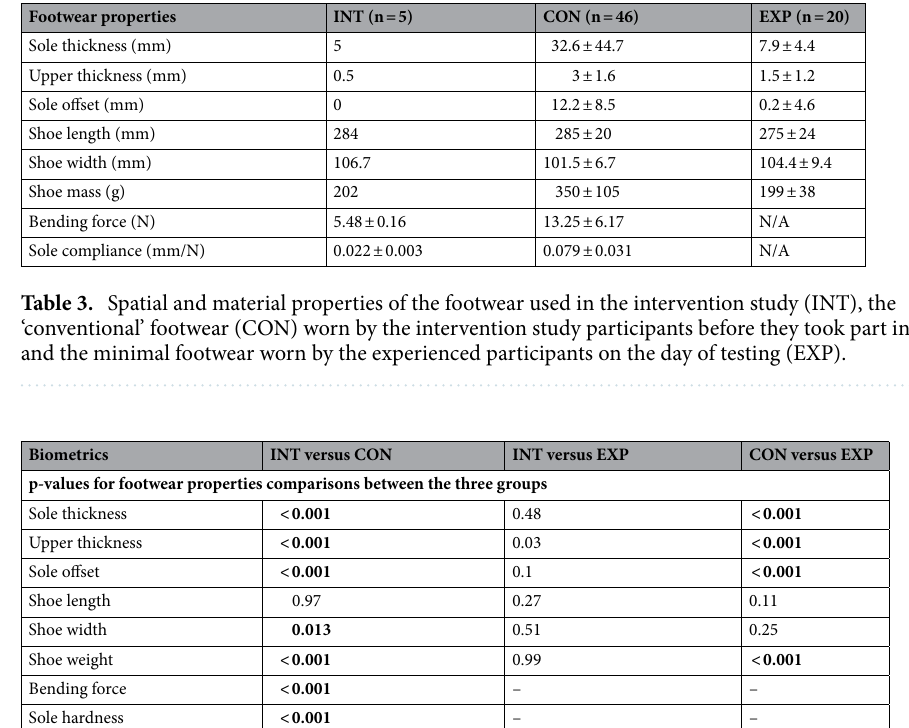
Table 4. Spatial and material properties: test results of the statistical comparison between the footwear used in the intervention study (INT), the “conventional” footwear worn by all intervention study participants but before they took part in the study (CON) and the footwear worn by the experienced participants on the day of testing (EXP). Significance level is set at P < 0.05.